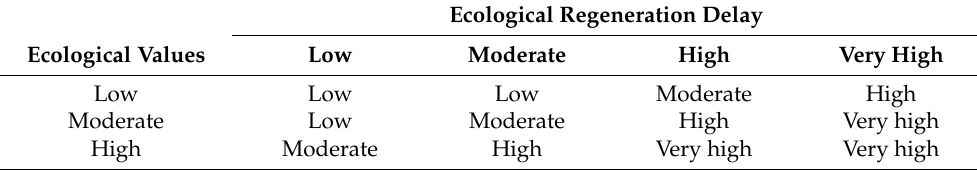
Table 9. Landslide ecological vulnerability resulting from the landslide ecological values and the ecological regeneration